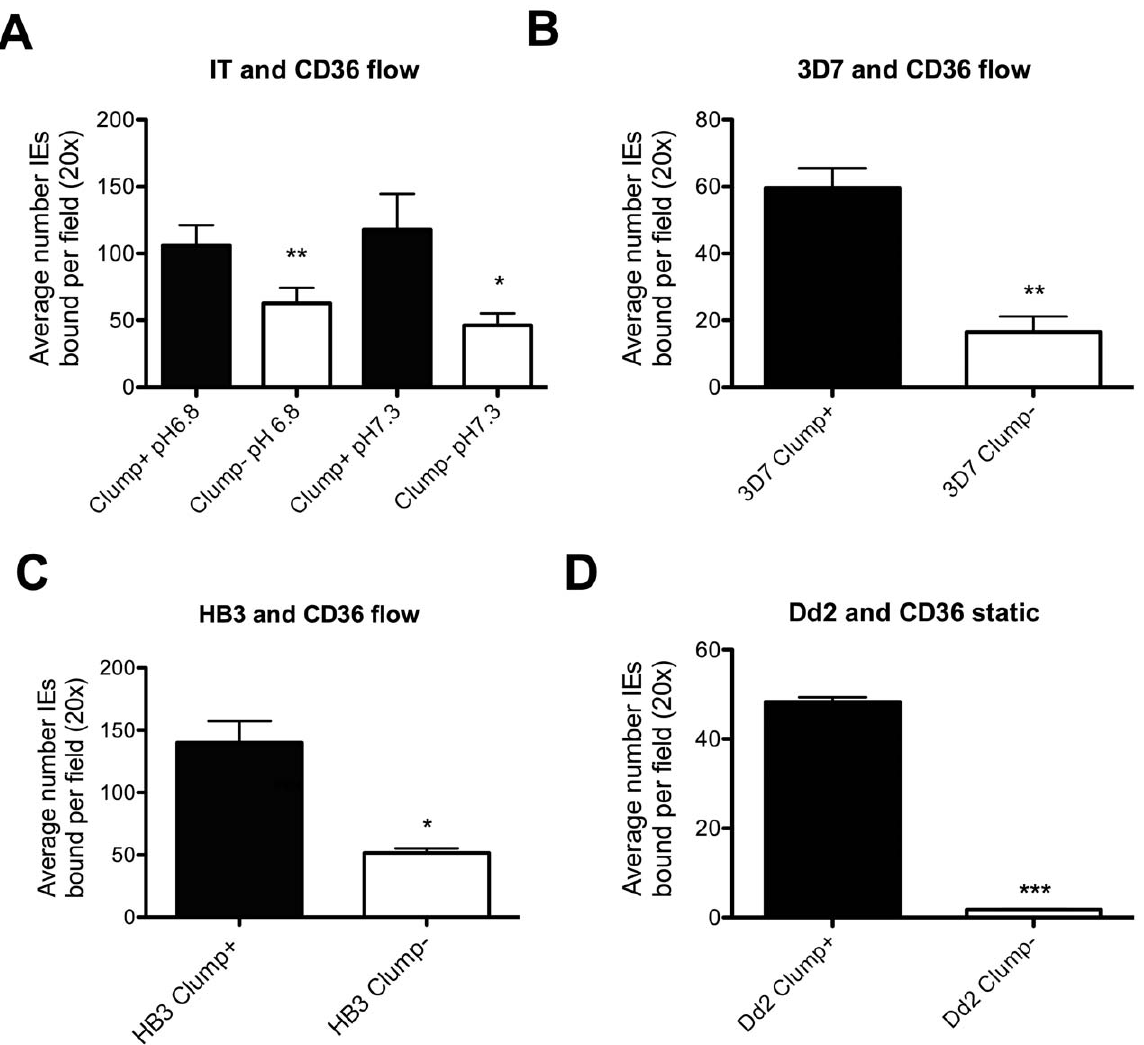
Figure 5. Comparison of CD36-binding by P.falciparum Clump + and Clump 2 parasite strains. (A) Binding of parasite strain IT to CD36 under flow conditions (0.05 Pa). Parasite cultures at 3% Pt, 1% Ht in BM/1%BSA at either pH 7.3 or pH 6.8 were flowed over microslides coated with 5 m g/ml recombinant CD36. After washing away unbound cells, the numbers of stationary cells per 20 6 magnification microscope field were counted by direct microscopic observation in six separate areas on the microslide. Binding of an uninfected E control suspension to CD36 was negligible in all experiments. Data shown are mean and SE of data from eight experiments. The Clump + parasites had 56–89% CF and the Clump 2 parasites had 0– 11% CF. Clump + parasites showed significantly higher binding to CD36 than Clump 2 parasites at both pH conditions (pH 7.3 p=0.0247; pH 6.8, p=0.0008; paired t test, n=8 at each pH). (B) Binding of parasite strain 3D7 to CD36 under flow conditions (0.05 Pa). Parasite cultures at 3% Pt, 1% Ht in BM/1%BSA at pH 7.3 were flowed over microslides coated with 5 m g/ml recombinant CD36. Washing and counting were as described above. Data shown are mean and SE from six experiments. The Clump + parasites had 22–39% CF and the Clump 2 parasites had 0% CF in all experiments. Clump + parasites showed significantly higher binding than Clump 2 parasites (p=0.0032, paired t test) (C) Binding of parasite strain HB3 to CD36 under flow conditions (0.05 Pa). Conditions as in (B). Data shown are mean and SE from four experiments. The Clump + parasites had 43–62% CF and the Clump 2 parasites had 0–5% CF. The Clump + parasites showed significantly higher binding than Clump 2 parasites (p=0.0118, paired t test).